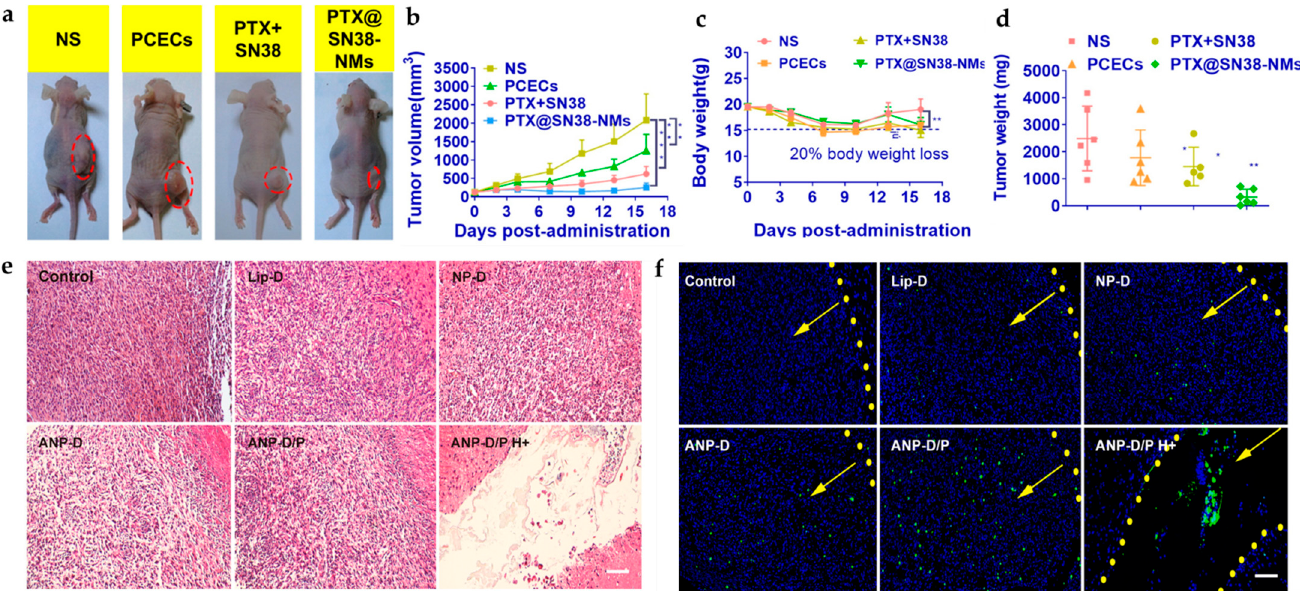
Figure 9. In vivo antitumor efficacy of nanoparticle-drug system ( a ) shown for different systems of NS (control), PCECs (composite), PTX@SN38 (dual-drug), and PTX@SN38-NMs. ( b ) Tumor volume (mm 3 ), ( c ) body weight loss study, and ( d ) tumor weight (mg). The data are represented as the mean ± SD; * p < 0.05, ** p < 0.01, and *** p < 0.001 [125]. Anti-glioblastoma efficacy shown by ( e ) H&E staining and ( f ) TUNEL assay of U87 MG glioblastoma tissues treated with different Dox formulations (Lip-D, NP-D, ANP-D, ANP-D/P, and ANP-D/P H+). Green represents the TUNEL-positive cells; blue, cell nuclei; and the yellow dashed line, the border of the glioblastoma. The yellow arrows indicate the direction of the glioblastoma (scalebar = 100 μ m) [134]. Adapted with permission from Refs. [125,134]. Copyright 2021 Elsevier and 2017 American Chemical Society.